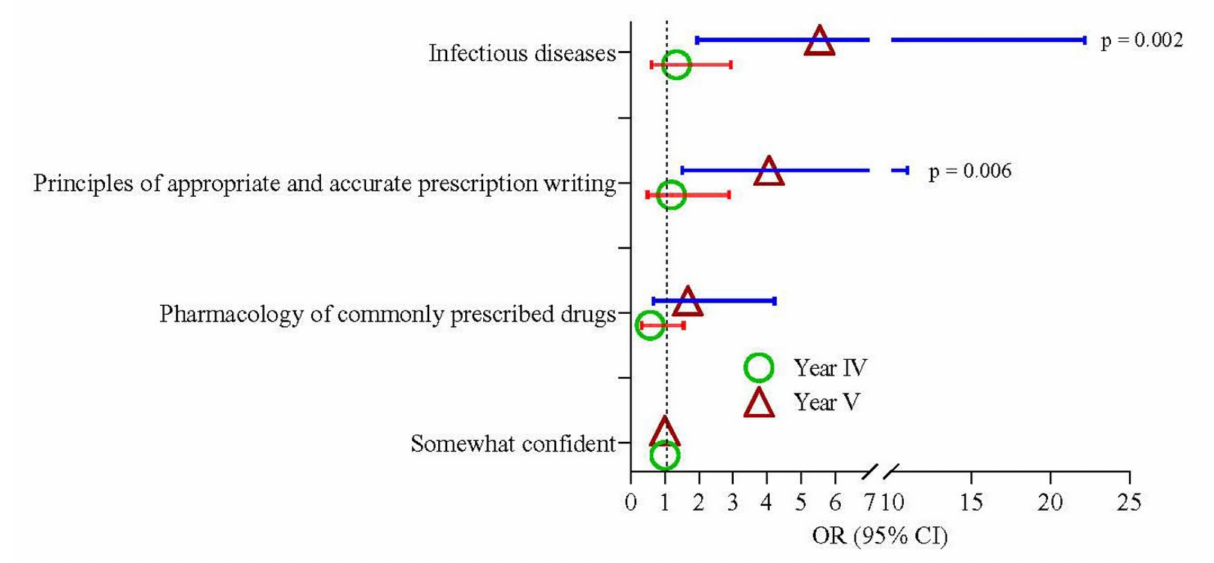
Figure 3. Odds of confidence in knowledge among the Year-IV and Year-V medical students com- pared to Year-III. Triangle and circle denote the estimation of odds ratios of Year-IV and Year-V student,